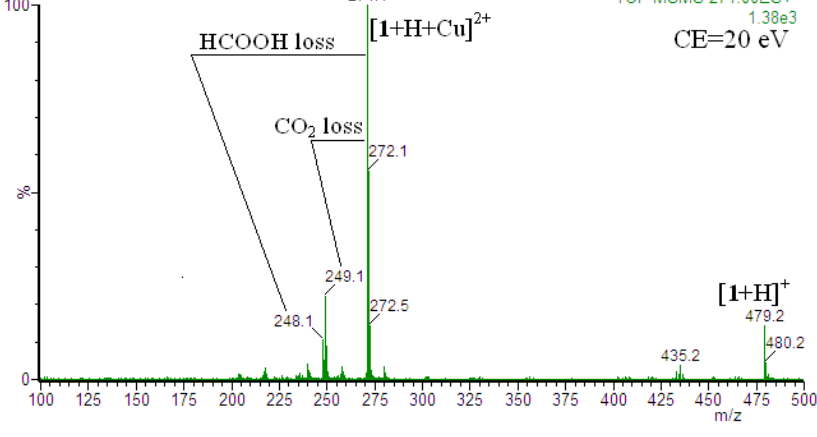
Figure 3: CID-MS/MS spectrum of [ 1 +H+Cu] 2+ ion.